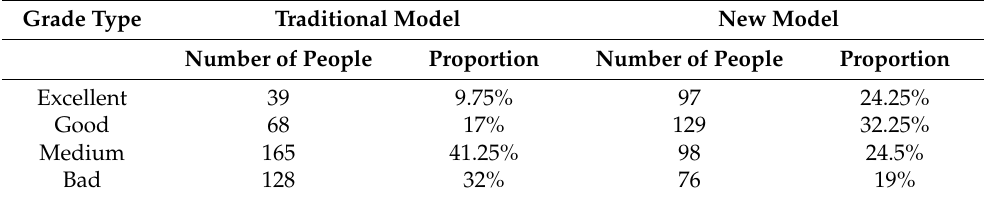
Table 1. Number and Proportion of Four Physical Test Results under Two Models.